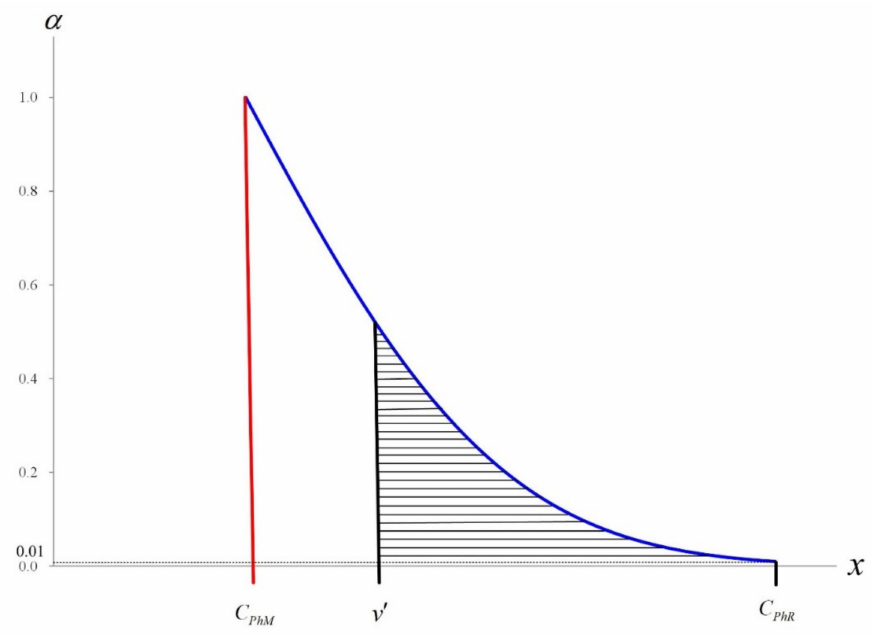
Figure 1. Membership function η h ( x ) with vertical line x = v (cid:48)